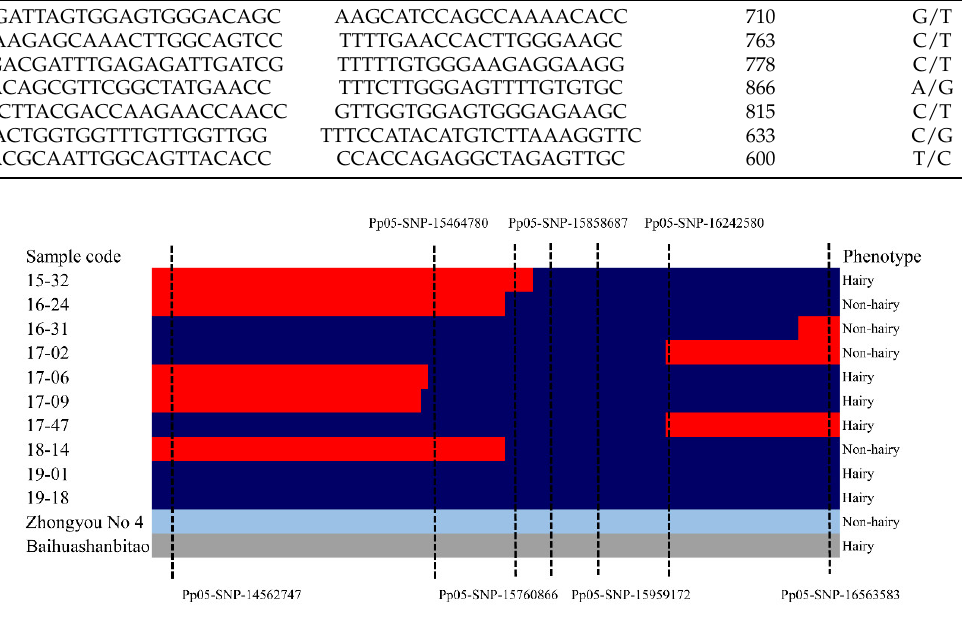
Figure 4. Genotype and phenotype of ten recombinants and two parents using 129 BC 1 Individuals for fine-mapping.